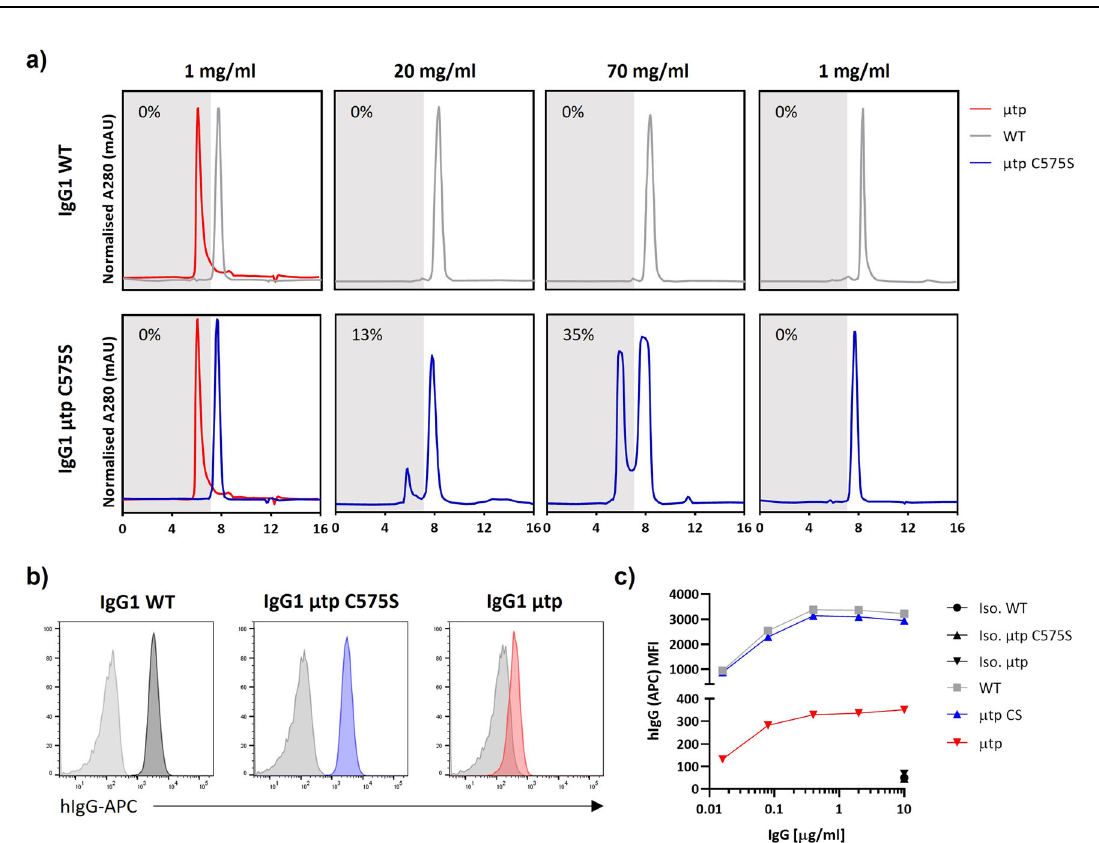
Fig. 2 Assessment of hexamerisation enhancement and antigen binding of IgG1 μ tp constructs. a Rituximab mAb constructs were concentrated up to 70 mg/ml and diluted to the required concentrations and analysed by SE-HPLC for the percentage of monomeric and multimeric species. Shown are SE- HPLC chromatagrams of hIgG1 wild-type and hIgG1 μ tp C575S overlaid with puri fi ed hIgG1 μ tp pre-formed hexamer trace prior to concentration, antibody concentrated to 20 mg/ml and 70 mg/ml, and post dilution back to 1 mg/ml. b Ramos cells were opsonised with rituximab hIgG1 μ tp mAb at 10 μ g/ml and binding measured by secondary anti-human Fc-APC-labelled antibody. Solid grey histograms indicate matched Herceptin hIgG wild-type and hIgG μ tp isotype control mAb. c Antibody binding (MFI) over a concentration range of rituximab hIgG μ tp and isotype control hIgG μ tp mAb binding Ramos cells (representative data